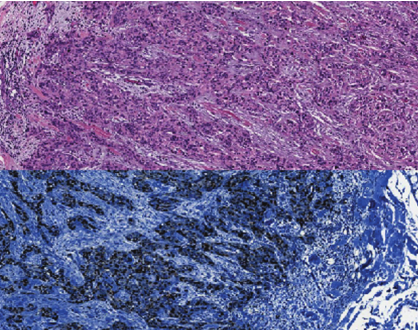
Figure 3: Tissue sample. The microscopic examination of the nodularlesionshowsparathyroidchiefcellsintrabecular,infiltrative pattern with fibrotic septae and vascular invasion. Immunohisto- chemical analysis revealed a nuclear overexpression of cyclin D1. Cyclin D1 stains the nuclei blue.